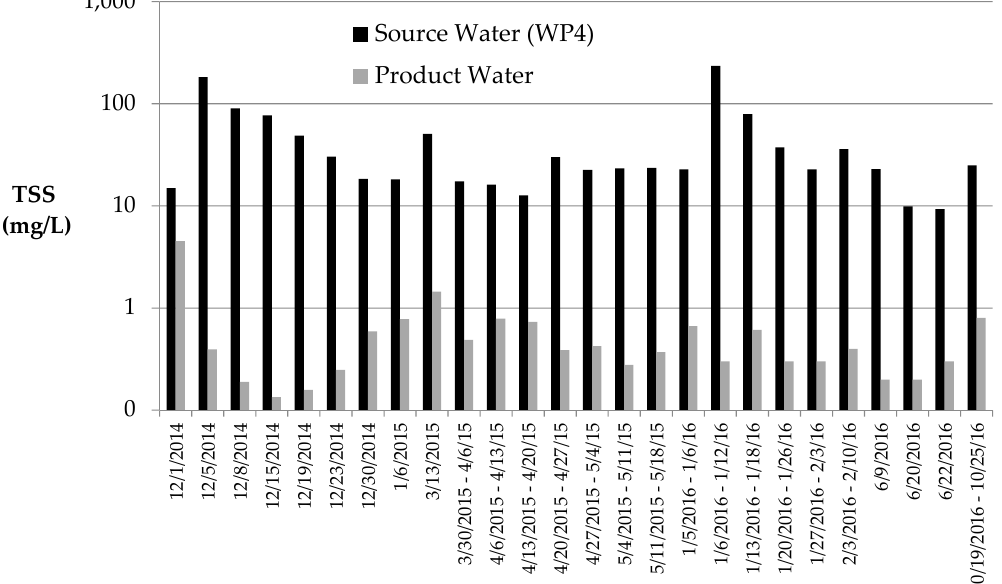
Figure 5. Total Suspended Solids in Source Water (WP4) and Product Water from RFS. (Note Log Scale, samples with a date range are weekly averages). Table 4. Changes in Selected Water Quality Constituents.